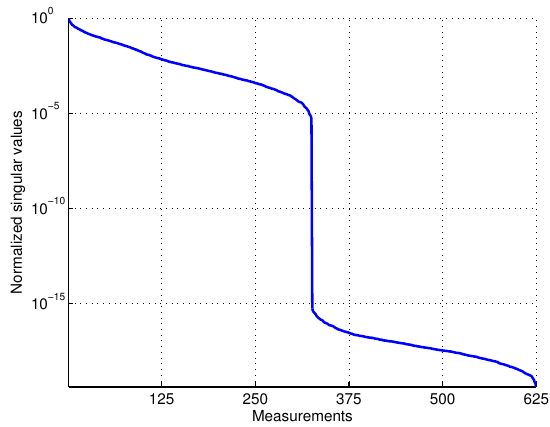
Fig.2: The normalized spectrum of the sigular values. The expo- nential decay illustrates the ill-posedness of the image reconstruc- tion. Fig.3: The realistic chest model and the coil arranegement used